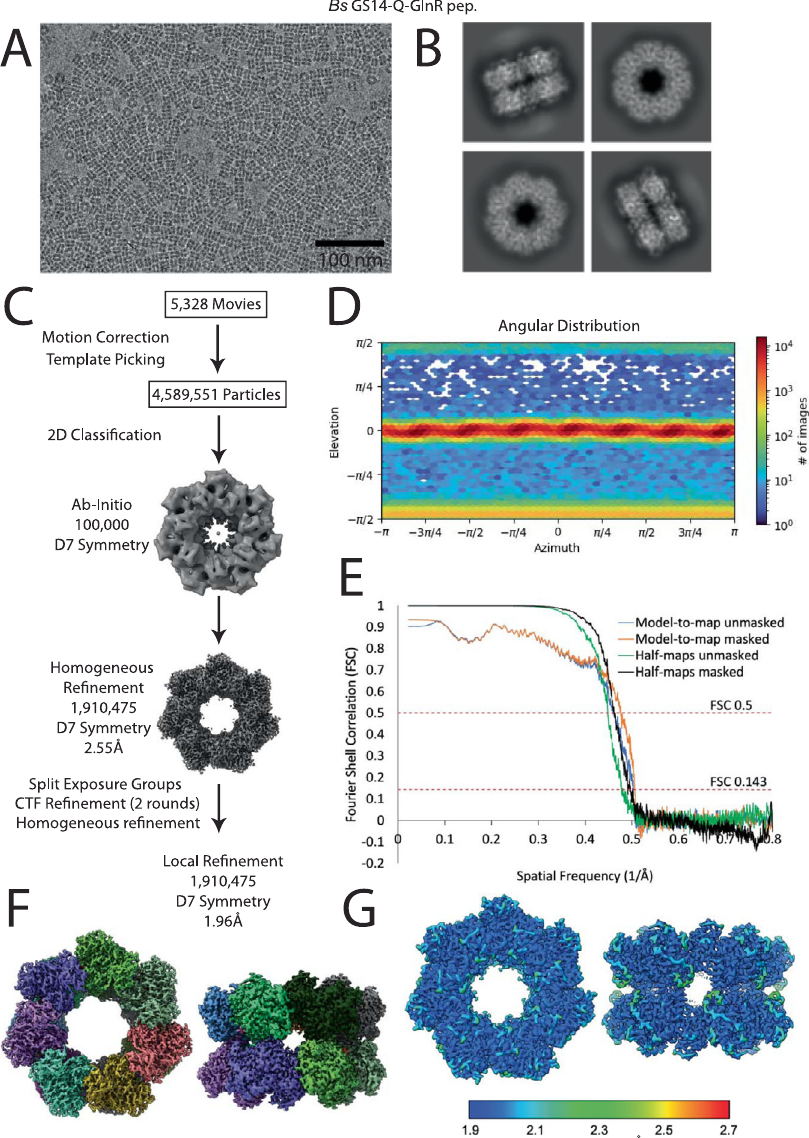
Fig. 2 Cryo-EM data processing of the Bs GS14-Q-GlnR peptide dataset. A A representative micrograph of the Bs GS14-Q-GlnR peptide complex on a holey gold grid. B Subset of the 2D classes showing top and side views of the tetradecameric complex. C Summary of the data processing work fl ow. D Angular distribution plot of the fi nal particle set. E Masked and unmasked half-map and model-to-map FSC curves. F Final sharpened map colored by GS subunit. G The GS structure is colored according to local resolution, with blue to red representing high to low-resolution,